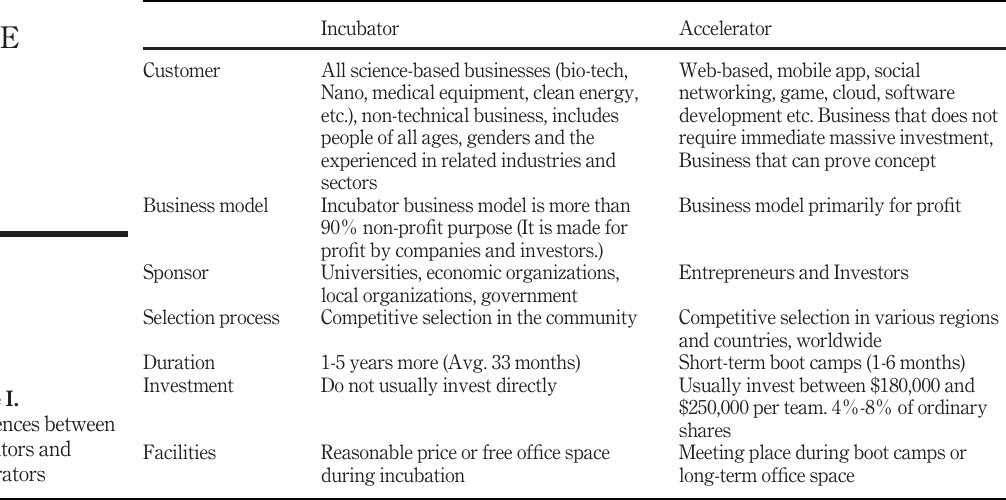
Table I. Differences between incubators and